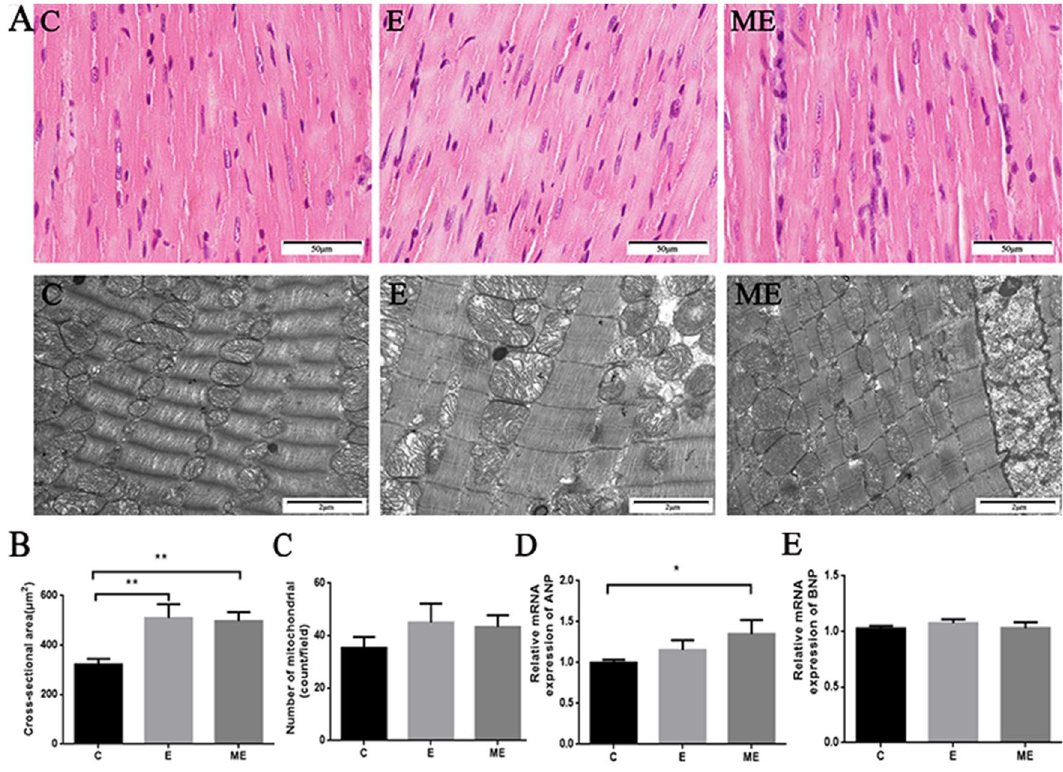
Figure 2. The effects of MOTS-c and exercise training on rat myocardial structure and hypertrophic genes. ( A ) is the HE staining (× 400) and TEM (× 20,000) images of the myocardium, which respectively reflect the gross and ultrastructure of the myocardium. The arrow is the lysosome. ( B ) Quantification of cross-sectional area of cardiomyocytes from H&E-stained sections. ( C ) Quantitative analysis of the number of myocardial mitochondria in TEM. ( D and E ) The mRNA expression of ANP and BNP. * p < 0.05, ** p < 0.01, compared to group C. C = Control, E = Exercise training, ME = Exercise training combined with MOTS-c